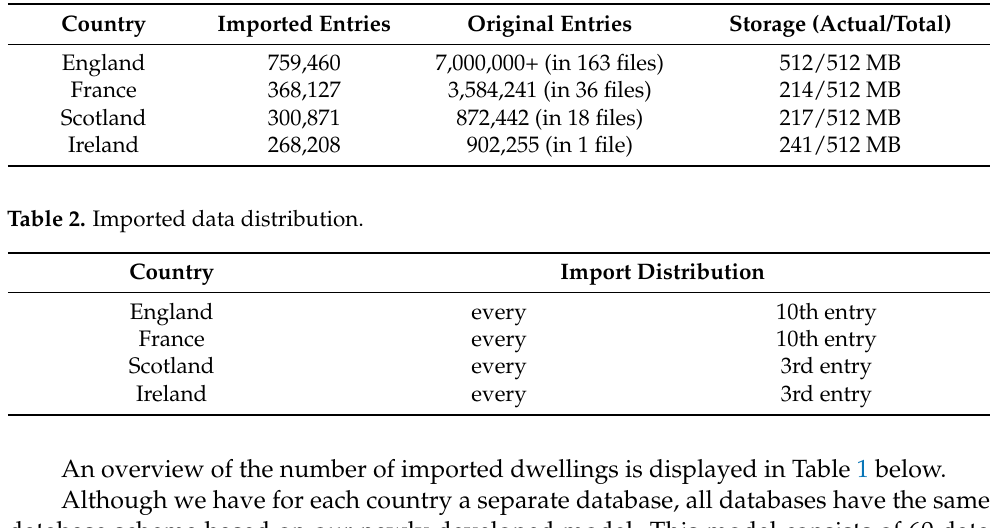
Table 1. Imported data amount.